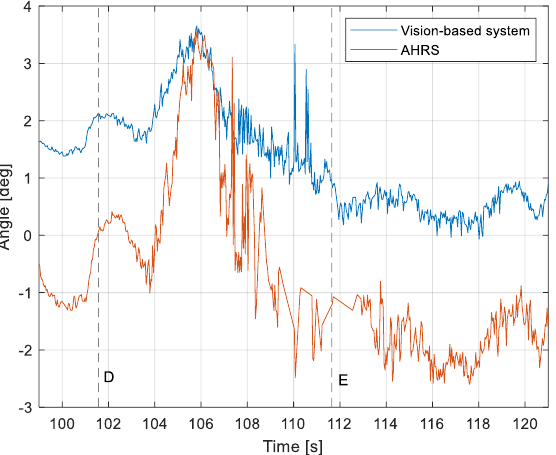
Figure 21. Angle between the longitudinal axis of the aircraft and the centerline: Flight no. 1 (markers D-E correspond to the moment of recording the images in Figure 9).